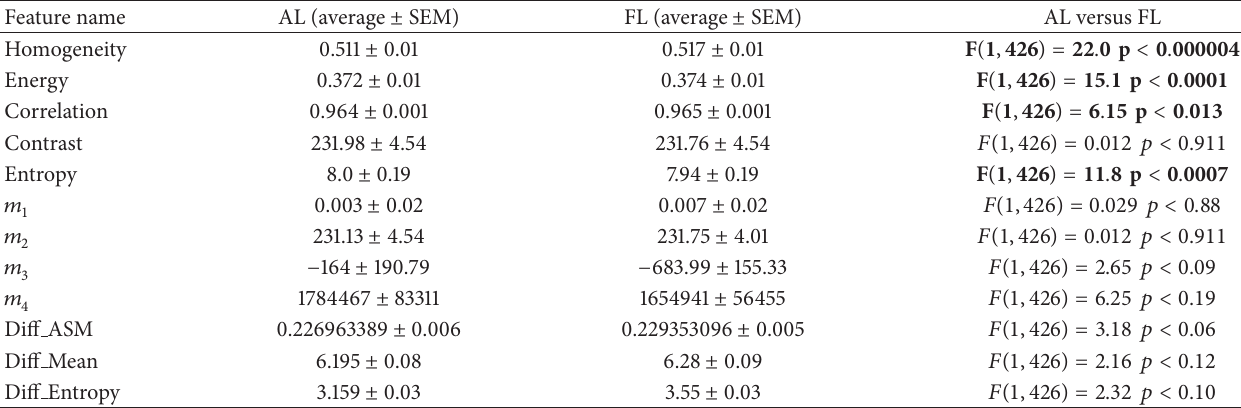
Table 1: ANOVA (1 within-subject factor) results for cancer patients Haralick texture features (comparison between AL and FL). AL: affected lung; FL: fellow lung.